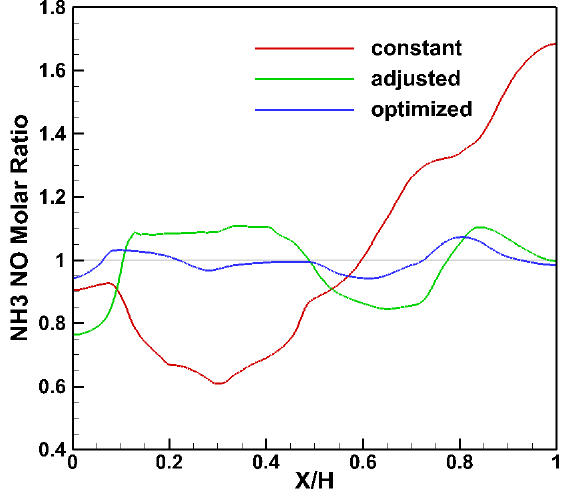
Figure 20. Comparison of NH 3 /NO ratio at the inlet of the catalyst layer for the random profile.